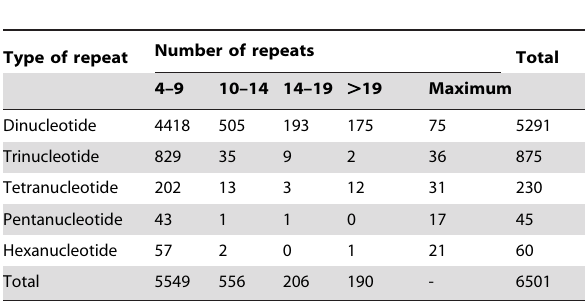
Table 4. Type and number of repeats of the microsatellites detected in the herring contigs using